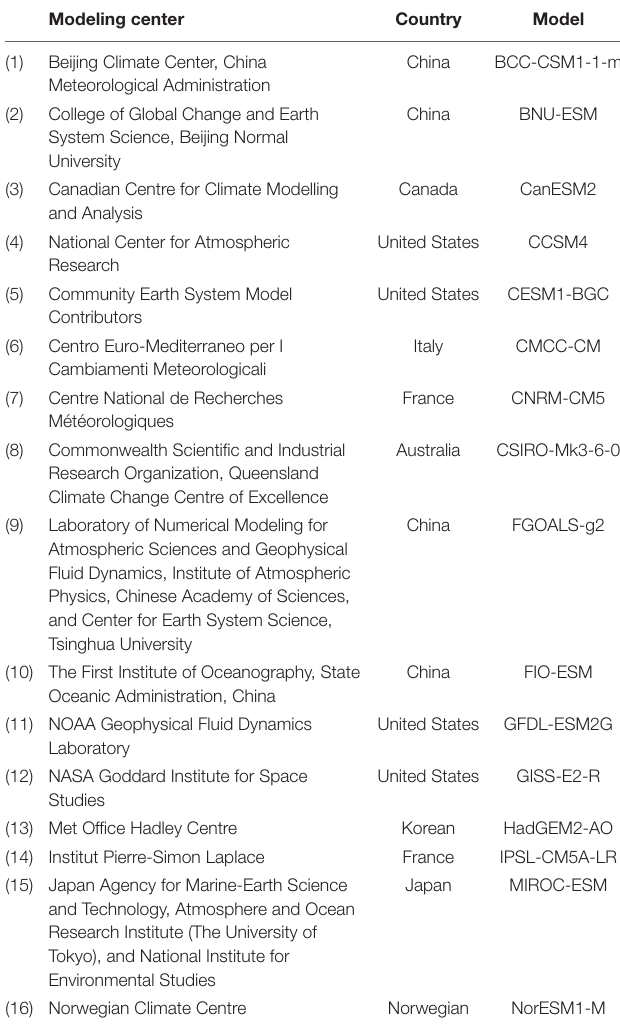
TABLE 1 | List of the Global Climate Models (GCMs) studied in this study. Modeling center Country